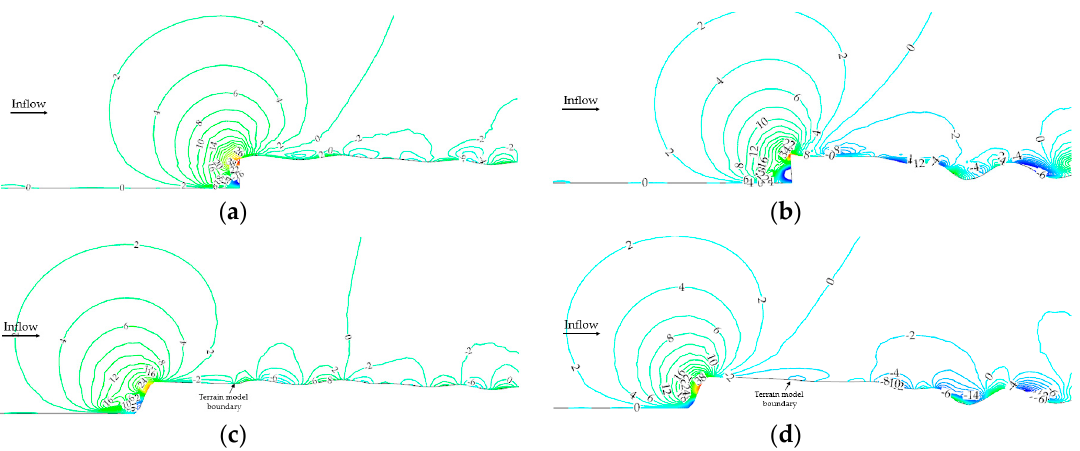
Figure 11. Turbulence kinetic energy distribution along the inflow direction near the inlet of the terrain model without or with improved BTS from CFD simulation (unit: m 2 s − 2 ). ( a ) Case 1 without BTS; ( b ) Case 2 without BTS; ( c ) Case 1 with BTS; ( d ) Case 2 with BTS.